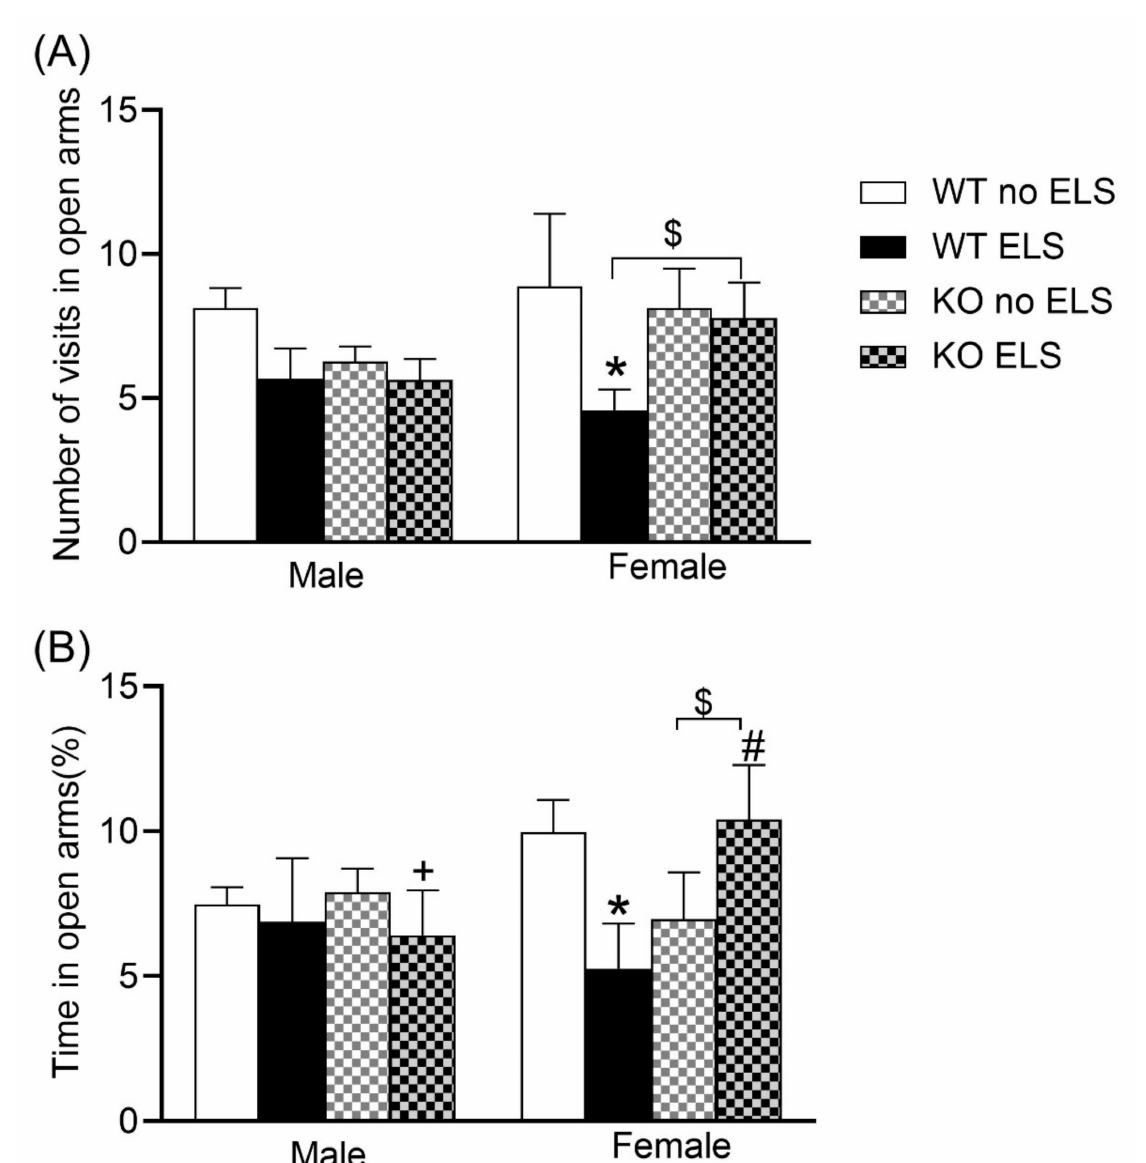
Figure 2. Effect of early life stress on WT and GPR37KO mice in elevated plus maze test. Frequency in open arms ( A ). Percent time spent in open arms ( B ). N/group: WT no-ELS male = 8, WT ELS male = 7, KO no-ELS male = 10, KO ELS male = 8, WT no-ELS female = 8, WT ELS female = 7, KO no-ELS female = 8 and KO ELS female = 9. All data represent mean ± SEM. * p < 0.05 treatment difference within genotype; # p < 0.05 versus corresponding WT; + p < 0.05 with respect to sex; $ p > 0.05 < 0.1 calculated by three-way ANOVA followed by multiple comparisons using the two-stage linear step- up procedure of Benjamini, Krieger and Yekutieli. WT = Wild Type, KO = Knockout, ELS = Early Life